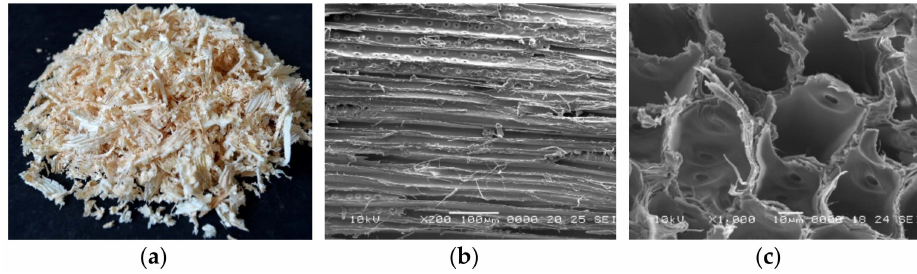
Figure 1. Fir sawdust used for composite plates: ( a ) overall aspect of fir sawdust; SEM images with a magnification of ( b ) × 200 and ( c ) ×